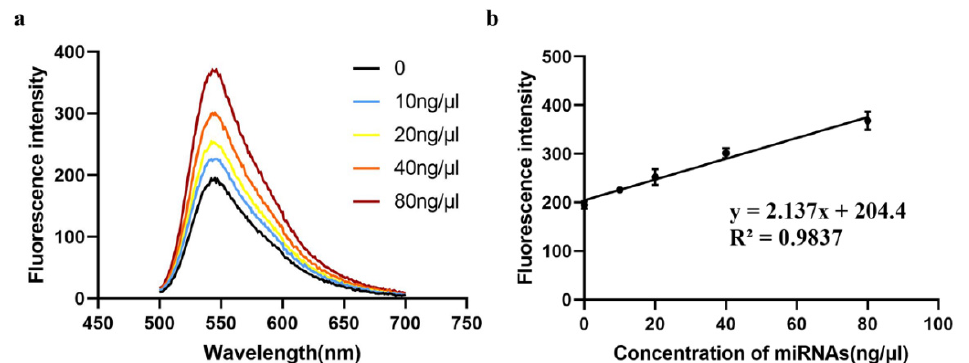
Figure 8. The assay of biological samples. ( a ) The fluorescence emission spectra of samples with different concentrations of miRNAs ranging from 0 to 80 ng/ µ L; ( b ) the plot of correlation between concentration of miRNAs and fluorescence intensity. The concentrations of miRNAs of HT-29 cells were 0, 10, 20, 40, 80 ng/ µ L. The fluorescence intensities of different concentrations are presented as mean ± SD. Each concentration was performed in triplicate.